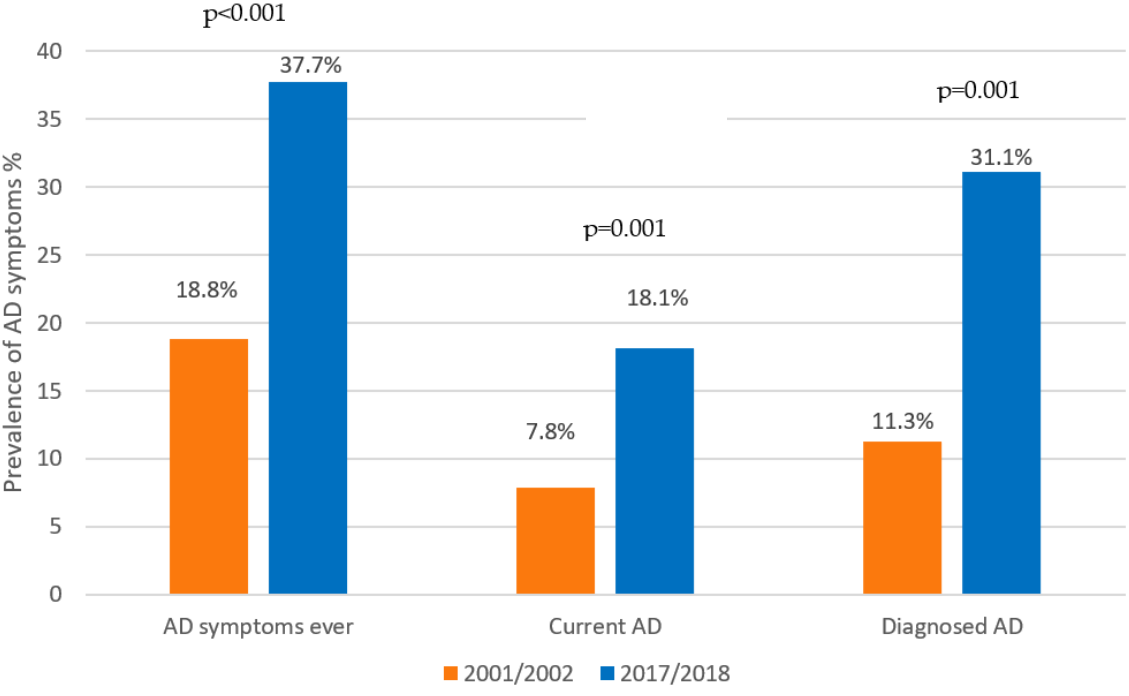
Figure 3. Significant rise in the self-reported prevalence of AD symptoms and diagnoses,